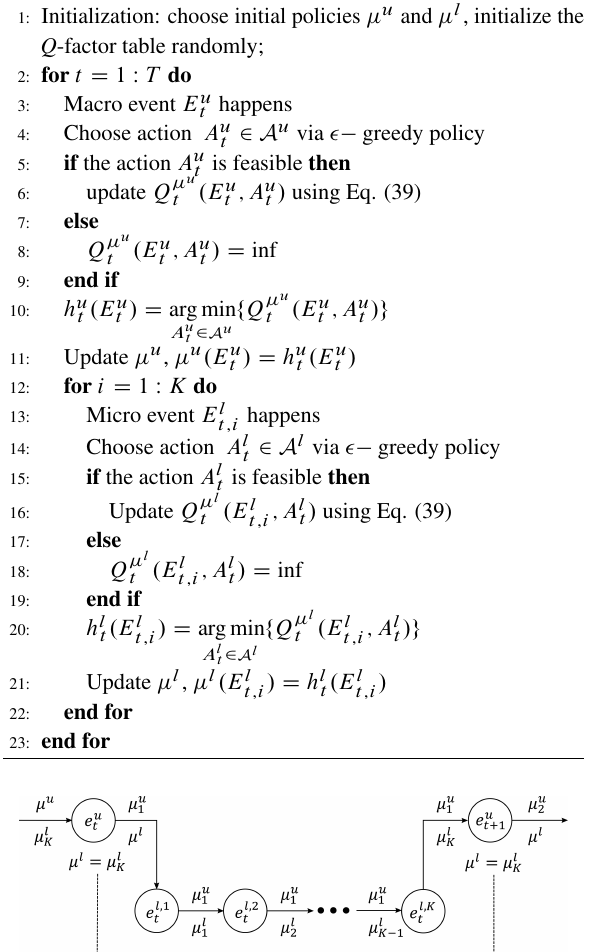
Algorithm 1 Bi-level event-based Q -learning algorithm